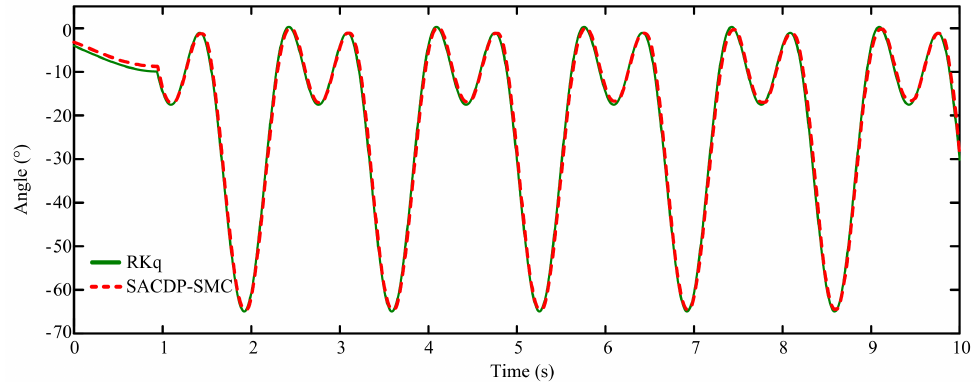
Figure 11. Trajectory tracking curve of the right knee joint.